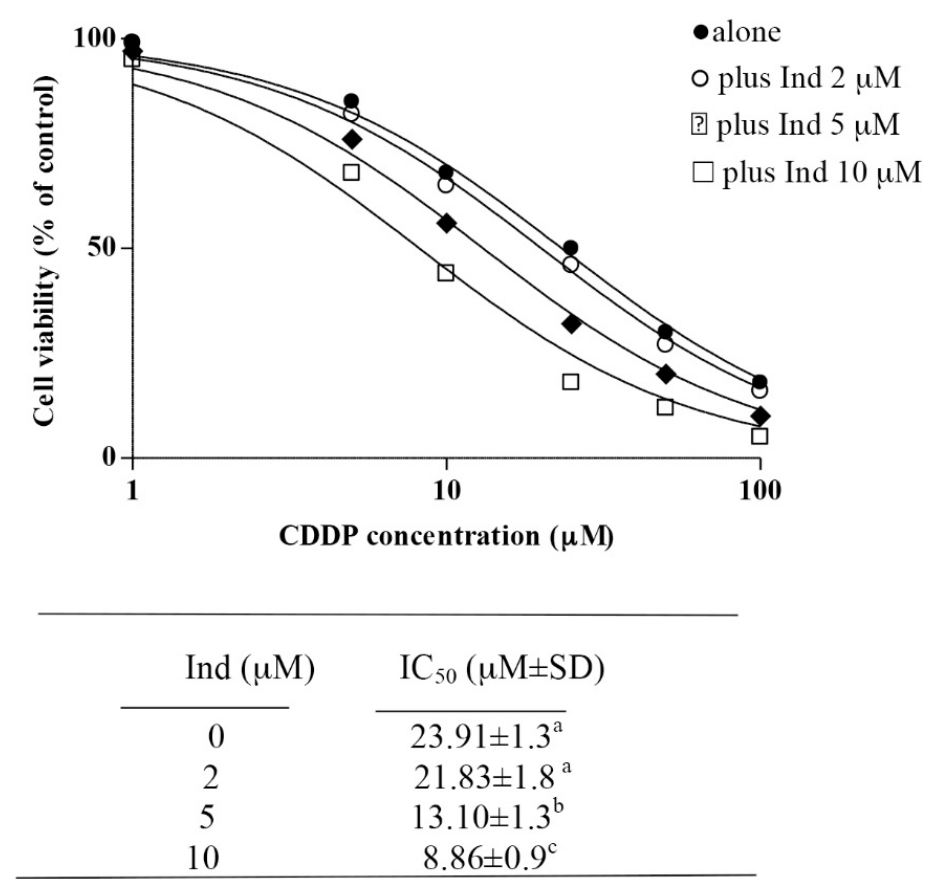
Figure 10. Cytotoxic effect of CDDP on HeLa cells in the absence or in the presence of not toxic Ind concentrations. Cells were treated for 24 h as described in Methods. IC 50 values are the mean ± SD of three separate experiments in triplicate. Means with different superscript letters are significant p < 0.05 (one-way Anova associated with Tukey’s post hoc test).